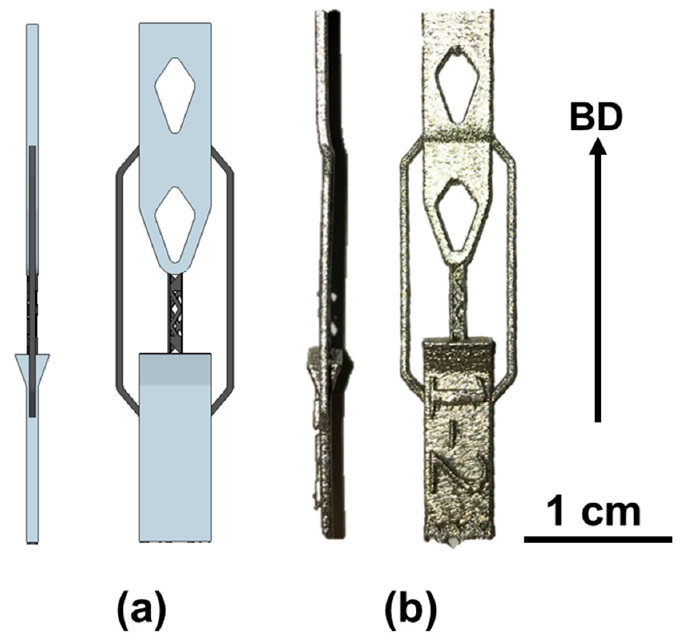
Figure 5 . Final design, cross-section, and the designation of support structures .